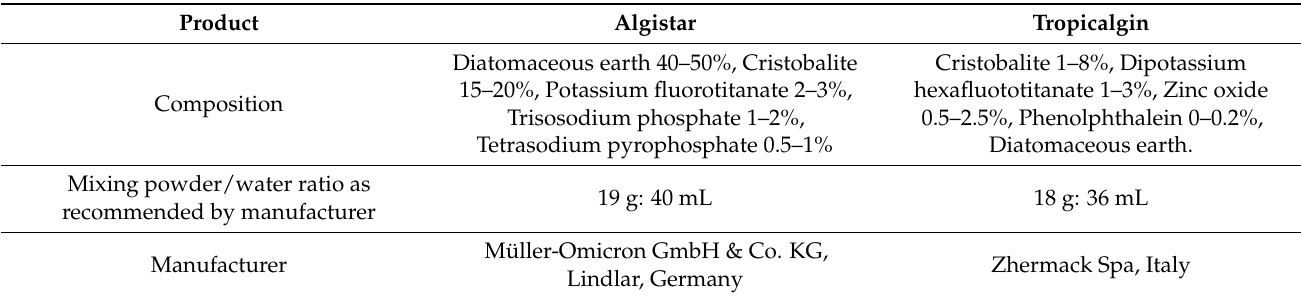
Table 1. Materials used, their composition and mixing powder/water ratio as recommended by manufacturers.